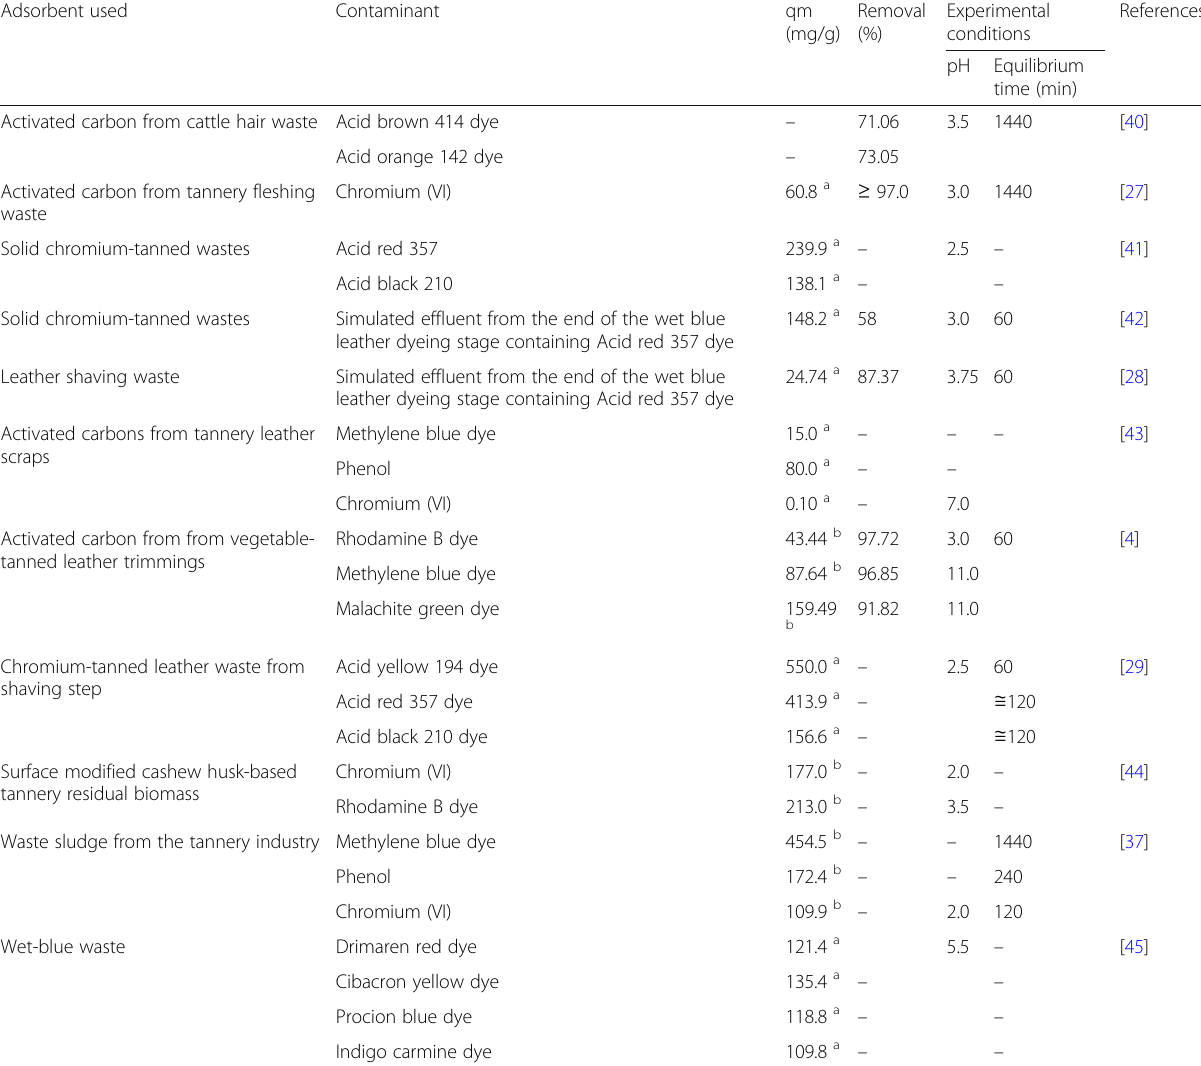
Table 1 Studies that used tannery wastes from various stages of leather processing as an adsorbent material Adsorbent